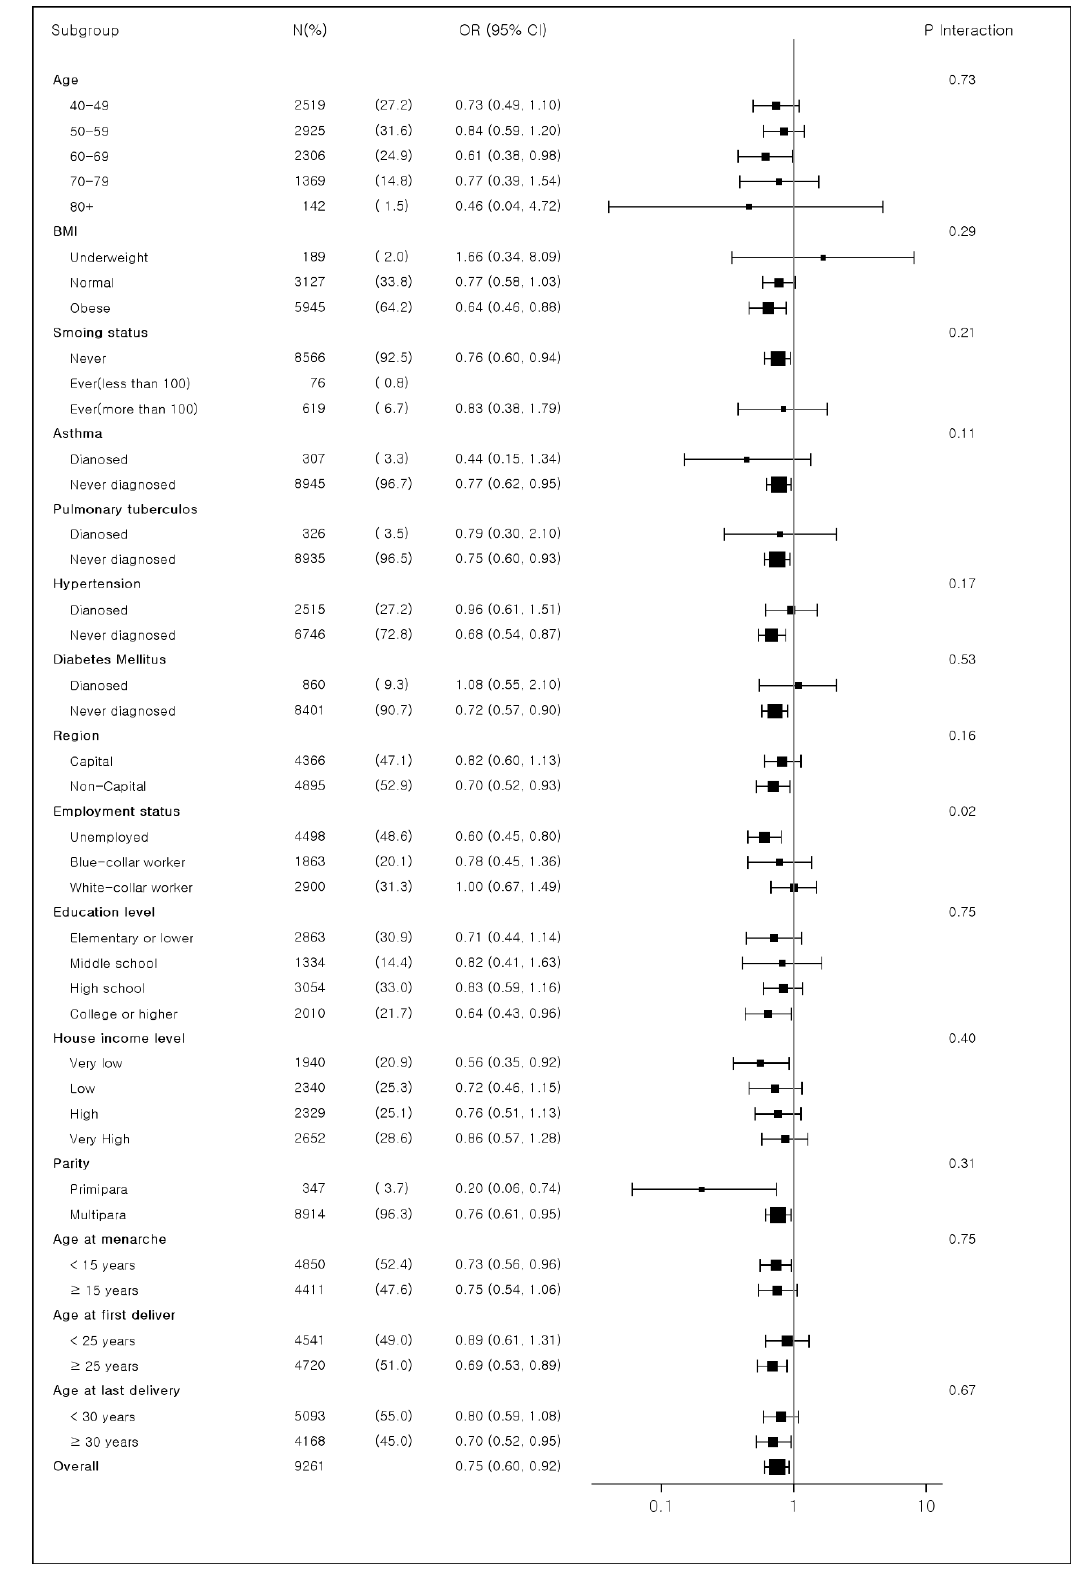
Figure 2. Forest plot of subgroup analysis of the association between breastfeeding and restrictive spirometric pattern stratified by covariates.